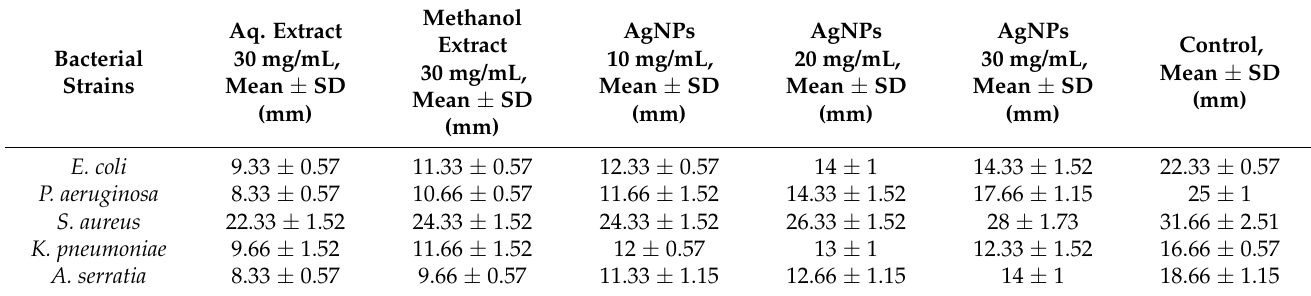
Table 1. Antibacterial activities of bark extract of Aesculus indica by Disc diffusion method.